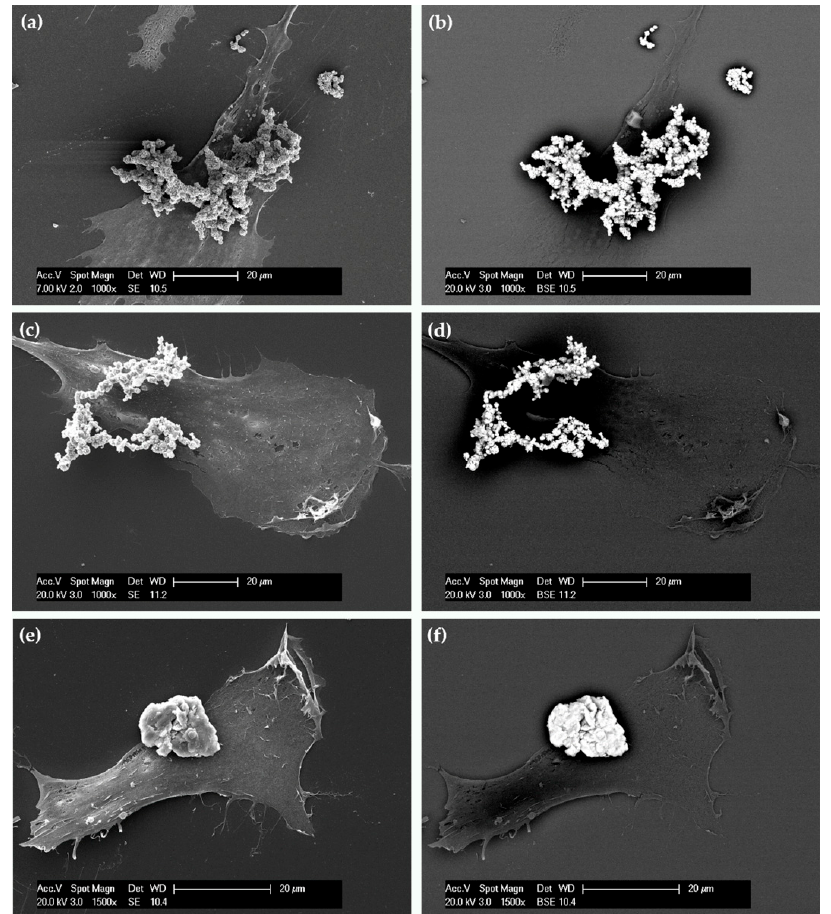
Figure 5. Scanning electron micrographs of typical hASCs exposed for 24 h to FeMPs ( a , b ), CoMPs ( c , d ), and NiMPs ( e , f ). The same field of view is shown with secondary electron (SE, left) and backscattered electron (BSE, right) imaging. In BSE imaging, the clusters of metal microparticles appear as bright spots.